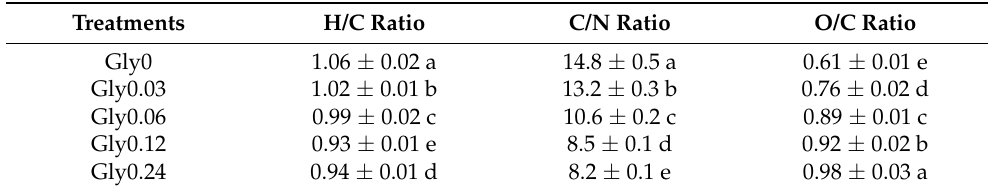
Table 2. Atomic ratios of the humic-like acid extracted from the dark-brown residue under different glycine concentrations in the Maillard